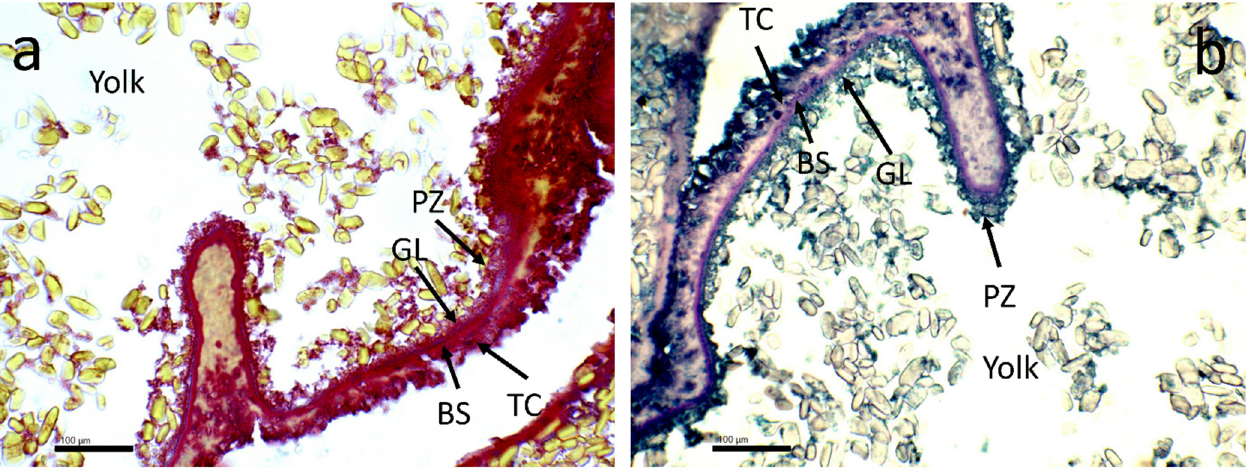
Figure 3. ( a , b ) Representative figures of mature oocyte showing four different layers: PZ = pellucid 149 zone, GL = granular layer, BS = basal surface, TC = theca cells, highlighted using Masson trichrome ( a ) and AB/PAS ( b ). Scale bars: 100 mm .